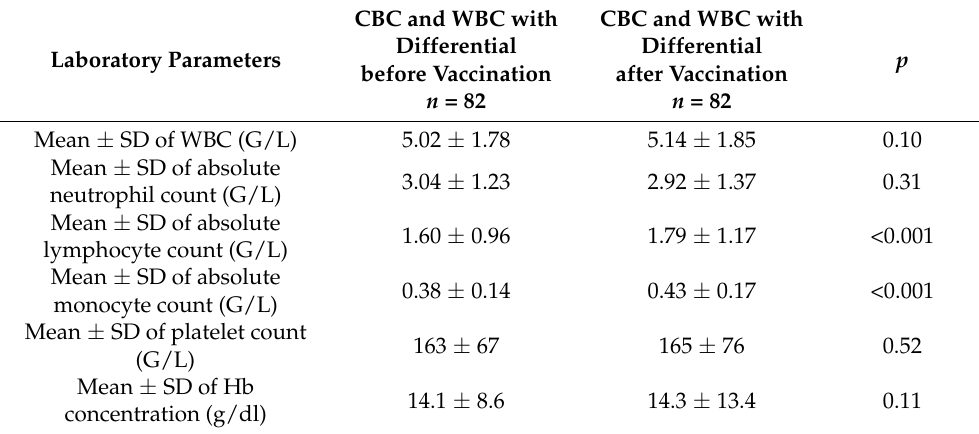
Table 7. Complete blood count and white-blood-cell count with differential before and after SARS- CoV-2 vaccination. CBC and WBC with CBC and WBC with Differential Differential p Laboratory Parameters after Vaccination before Vaccination n = 82 n = 82 Mean ± SD of WBC (G/L) Mean ± SD of absolute neutrophil count (G/L) Mean ± SD of absolute 1.60 ± 0.96 <0.001 lymphocyte count (G/L) Mean ± SD of absolute 0.38 ± 0.14 0.43 ± 0.17 <0.001 monocyte count (G/L) Mean ± SD of platelet count (G/L) Mean ± SD of Hb concentration